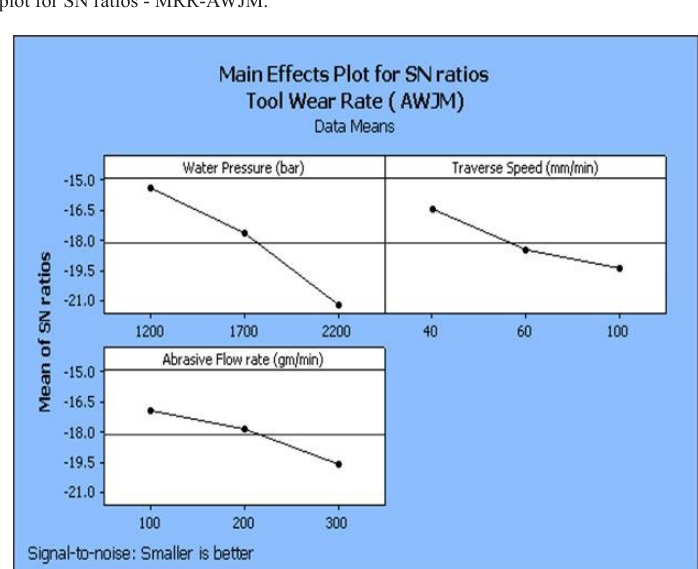
Figure 8. Main effects plot for SN ratios - TWR-AWJM.